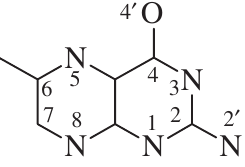
Figure 1 Pterin numbering scheme.